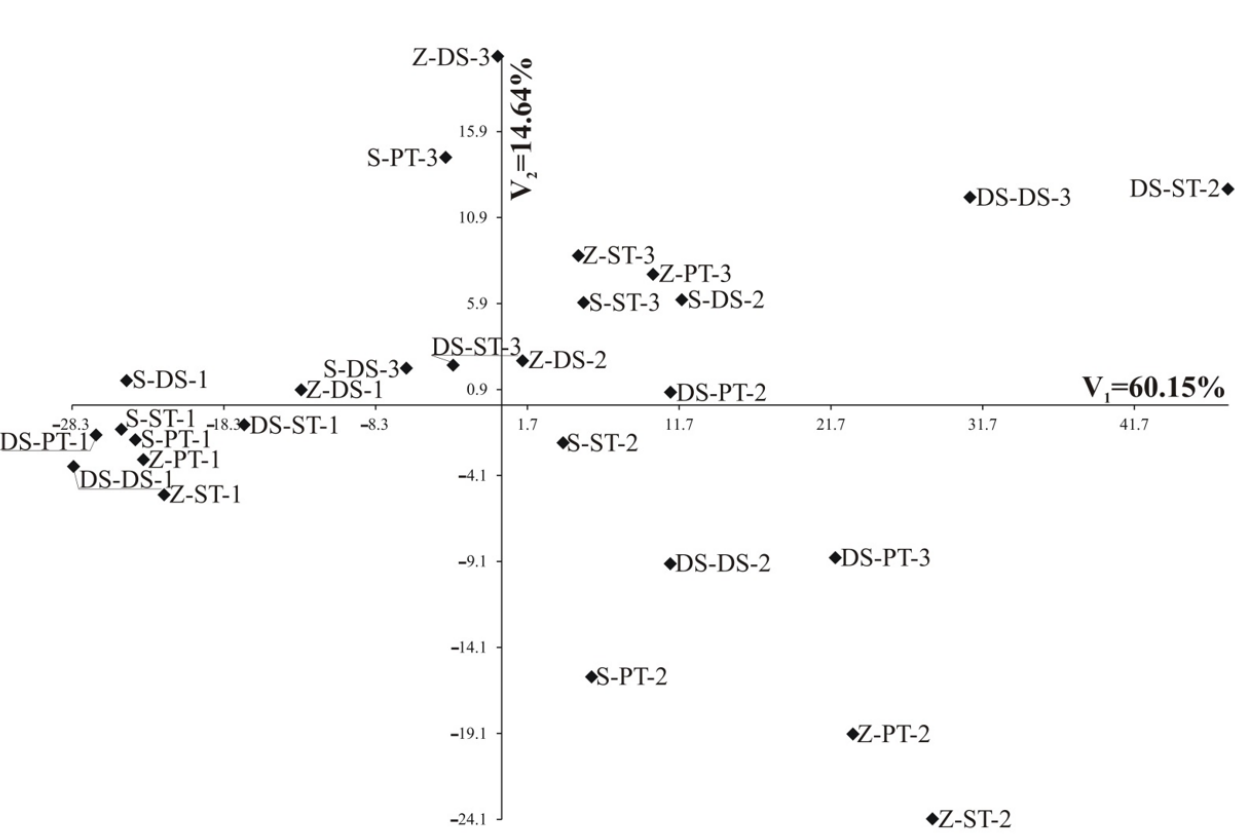
Figure 2. Distribution of the spring wheat treatments in the two first canonical variates at the 1st term (cover crop: Z—zero, S—skimming, DS—direct sowing, ST—simplified tillage, PT—spring ploughing; years: 1—2011, 2—2012, 3—2013).